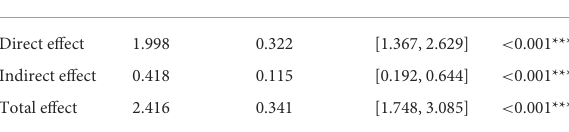
TABLE 11 Direct effect, indirect effect, and total